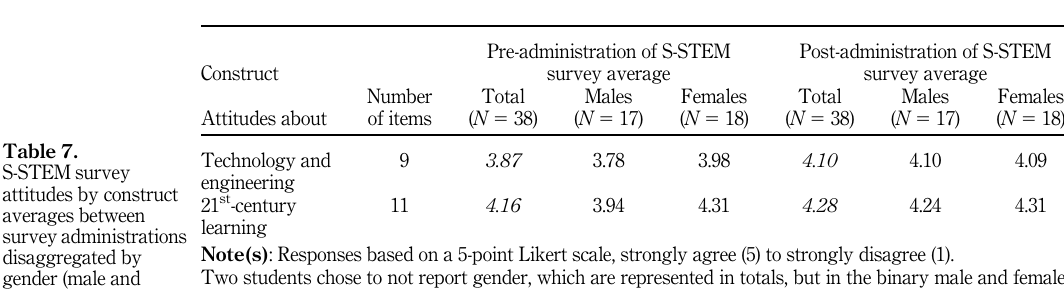
constructs and sub- constructs of students ’ responses ( n 5 32) to [overall] “ how did you interact with your group during the STEM challenge? ”